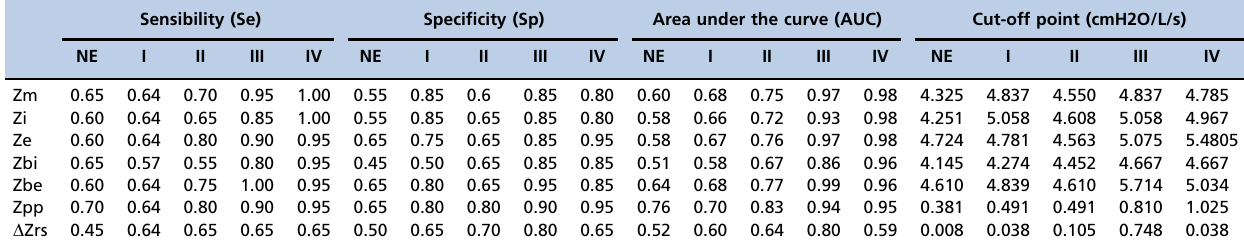
Table 3 - Sensitivity, specificity, and area under the curve values for the optimal cut-off points obtained using receiver operating characteristic